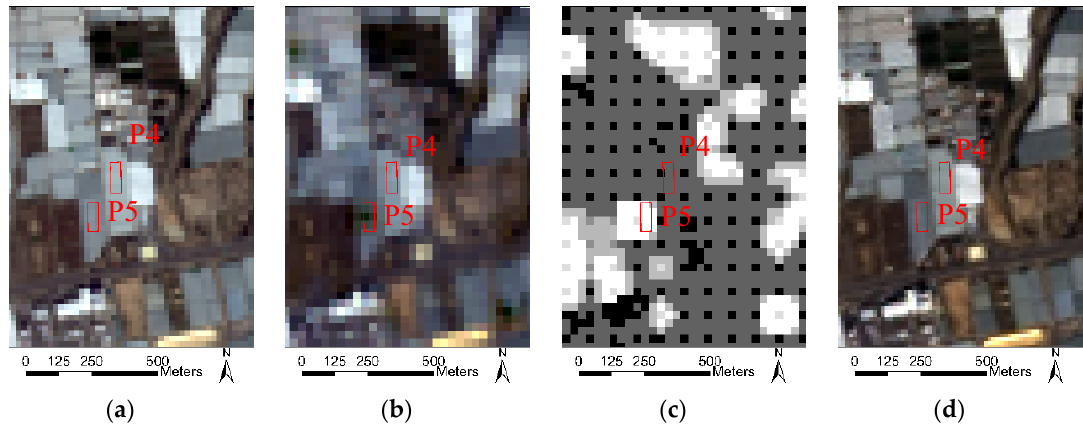
Figure 4. L8 and S2 products where is shown a detailed area belonging to Almería study site (SS1) including two polygons in red: ( a ) S2 L2A RGB, P4 (R: 30.57 to 28.08 (29.30), G: 31.54 to 29.13 (30.44), B: 30.02 to 27.70 (28.89)), P5 (R: 23.24 to 20.04 (21.89), G: 23.77 to 20.91 (22.42), B: 22.66 to 20.11 (21.51));